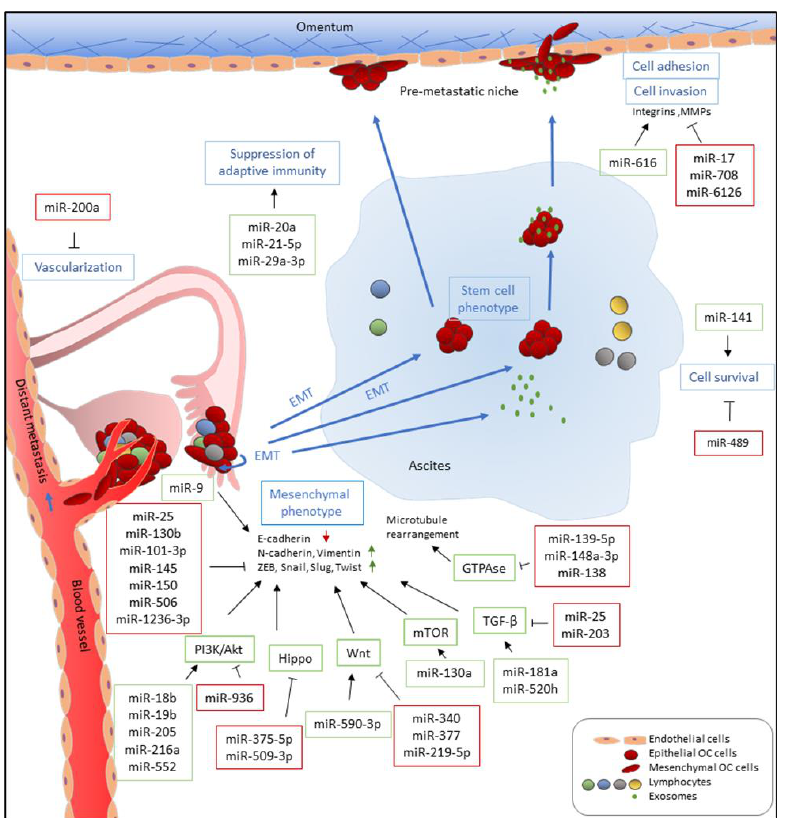
Figure 2. Functions of miRNAs in EOC metastasis. miRNAs which are upregulated and promote metastasis-related processes are depicted in green boxes while downregulated miRNAs which inhibit metastatic-related processes are listed in red boxes. miRNAs directly and indirectly regulate epithelial-to-mesenchymal transition (EMT) by targeting E-cadherin and E-cadherin repressors, such as ZEB, Snail, Slug, and Twist, and associated signaling pathways. miR-9 directly targets E-cadherin to activate EMT while miR-25, miR-101-3p, miR-130b, miR-145, miR-150, and miR-1236-3b directly inhibit expression of E-cadherin repressors, including ZEB1 , SNAI2 , and TWIST1 . Multiple miRNAs, such as miR-18b, miR-19b, miR-205, miR-216b, and miR-552, promote EMT by targeting PTEN , leading to the activation of the PI3K / AKT pathway. In addition, upregulation of miR-590-3p, miR-130a, miR-181a, and miR-520h induces Wnt, mTOR, and TGF- β signaling, respectively, which are known pathways that promote EMT. In contrast, miR-936, miR-375-5p, miR-509-3p, miR-340, miR-377, miR-219-5p, miR-25, and miR-203 attenuate PI3K / AKT, Hippo, Wnt, and TGF- β signaling pathways and inhibit cell migration, invasion, and EMT. Furthermore, downregulation of miR-139-5p, miR-148a-3p, and miR-138, which has been reported to inhibit ROCK s and LIMK1 expression, increases cell motility via GTPase signaling. Metastatic EOC cells float in ascites as single cells or spheroids which exhibit stem cell-like properties. To survive after detaching from primary site and inside ascites, metastatic EOC cells upregulate miR-141 and downregulate miR-489 to modulate anoikis resistance. In the transcoelomic pathway, EOC metastatic cells then adhere to the mesothelium lining and invade peritoneal organs. Upregulation of miR-616 and downregulation of miR-17 and miR-6126 increase cell adhesion via increased expression and activities of integrins and MMPs which recognize and degrade the extracellular matrix (ECM) of the mesothelial cells, respectively. In addition, downregulation of miR-708 increases focal adhesion formation through promoting focal adhesion kinase (FAK) activities. EOC metastasis occurs in an immune-suppressive environment which are modulated by miRNAs. miR-21-5p and miR-29a-3p promote adaptive immune suppression via upregulation of tumor-associated macrophages (TAMs) and induction Treg / Th17 imbalance while miR-20a downregulates MICA / B to avoid recognition by cytotoxic T-cells. Furthermore, EOC tumors increase vascularization and angiogenesis via downregulation of miR-200a, implicating them in distant metastasis through a perfusion